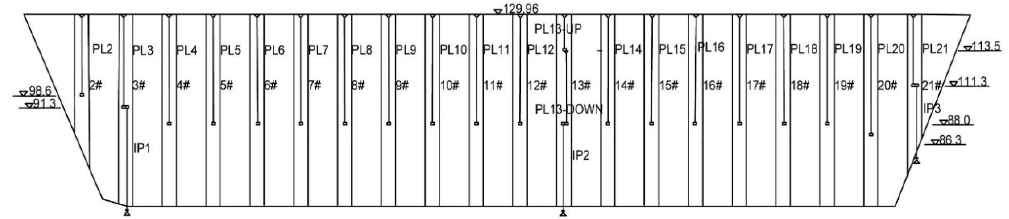
Figure 6. Layout of the multiple-arch dam.